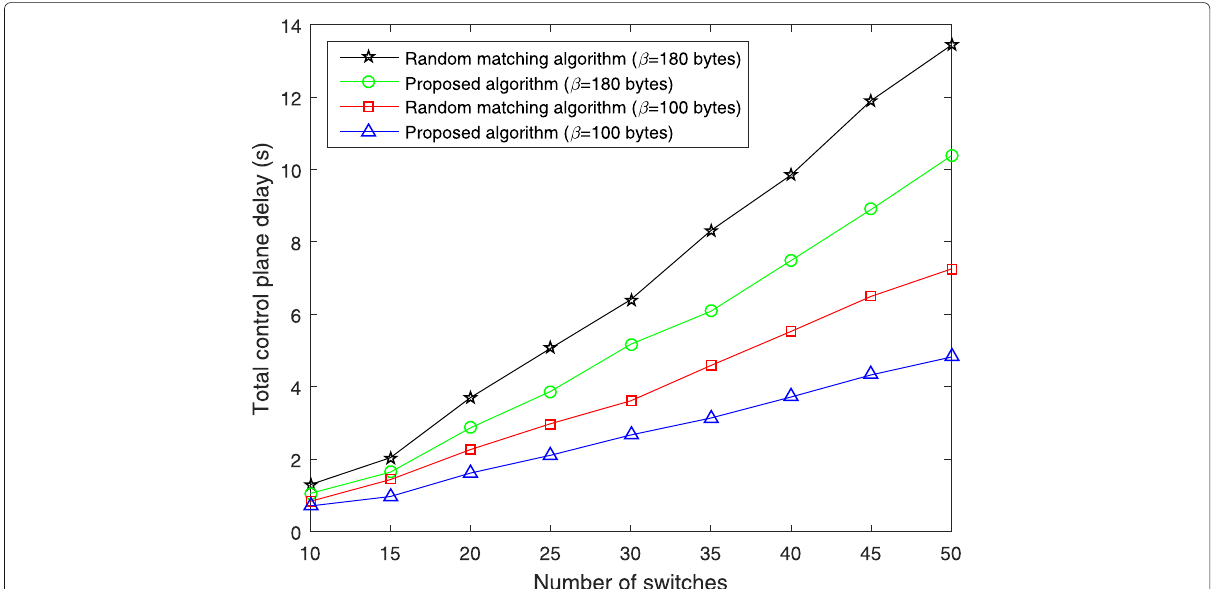
Fig. 8 Control plane delay versus the number of switches (different β ). The control plane delay versus the number of switches for different